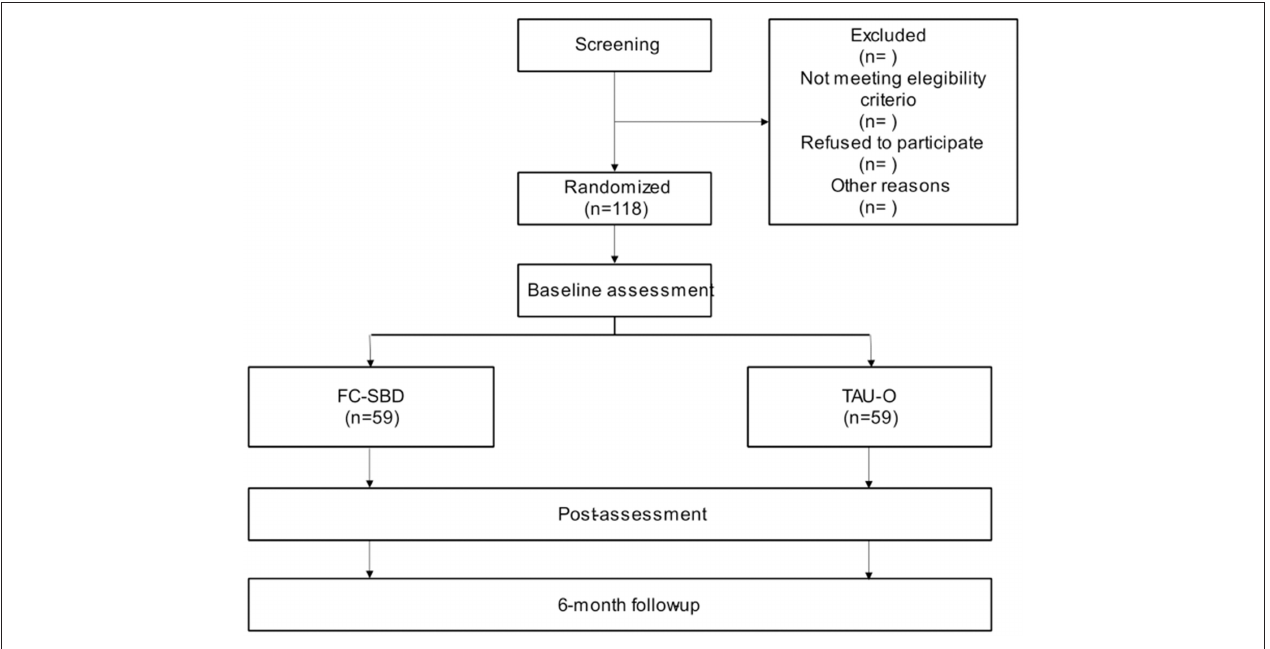
FIGURE 1 | Flowchart of the